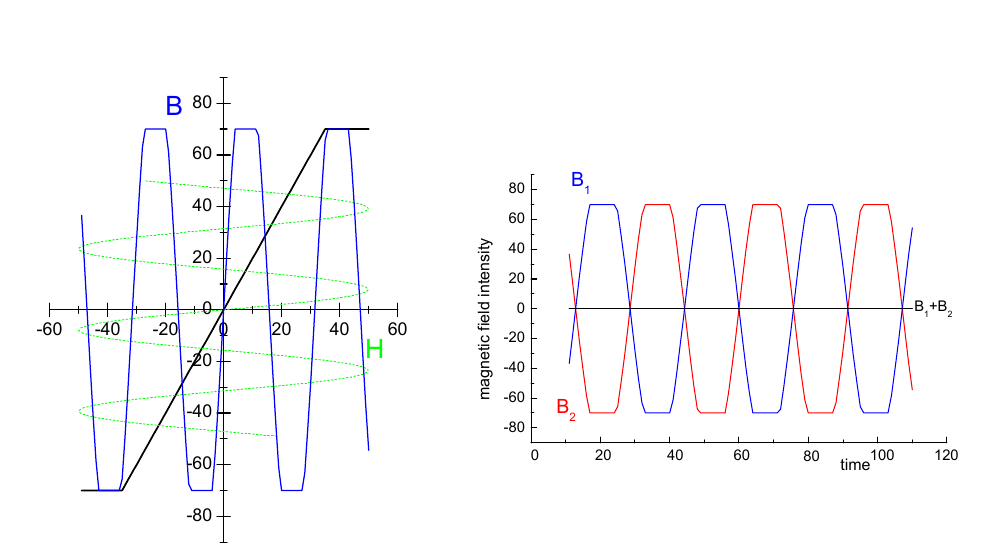
Figure 124: Left panel: This figure refers to any of the two sensitive elements of the magnetometer. The thick black line indicates the magnetic hysteresis curve, the dotted green line indicates the magnetizing field 𝐻 , and the thin blue line represents the magnetic field 𝐵 produced by 𝐻 in each bar. The thin blue line periodically reaches saturation producing a saturated magnetic field B. The trace of 𝐵 results to be symmetric around the zero line. Right panel: magnetic fields 𝐵 1 and 𝐵 2 produced in the two bars, as a function of time. Since 𝐵 1 and 𝐵 2 have the same amplitude but out of phase by 180 ∘ , they cancel each